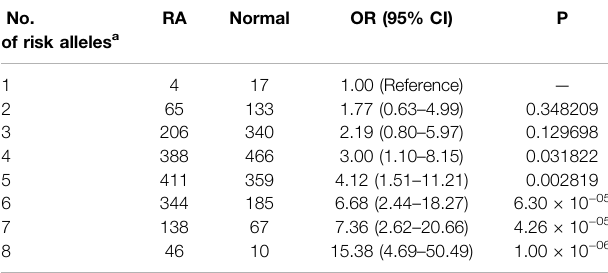
TABLE 5 | Cumulative risk effect of rheumatoid arthritis increased as more risk alleles were carried by patients. No. of risk alleles